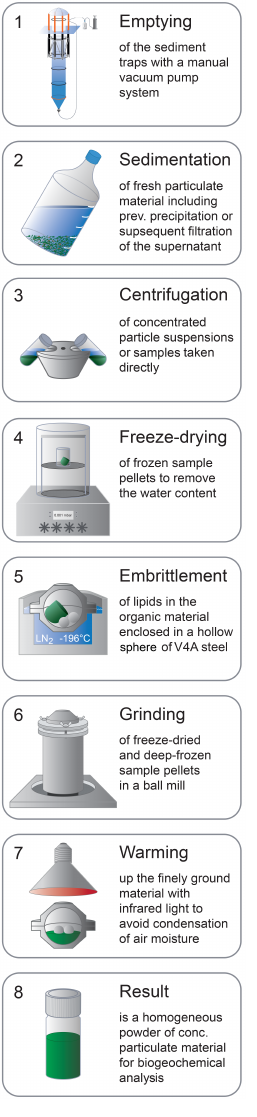
Figure 2. Protocol of mesocosm sediment trap sampling (1), par- ticle concentration (2–3), freeze-drying (4), and grinding (5–8) to convert heterogeneous sediment trap samples into homogeneous powder for biogeochemical